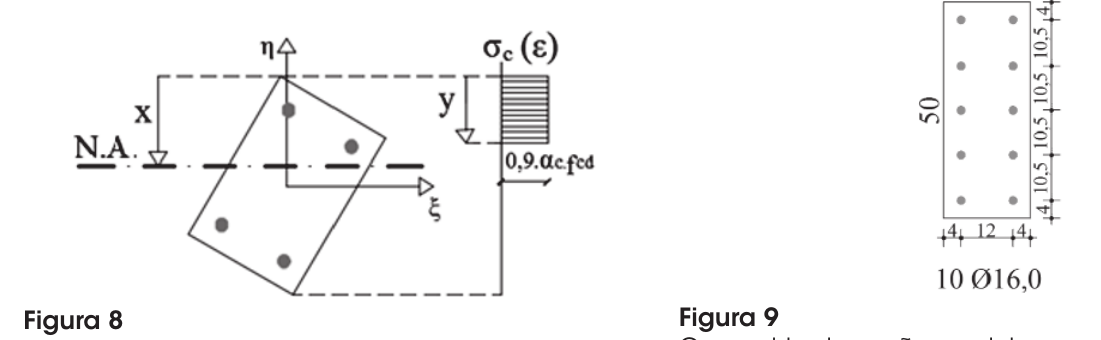
Geometria da seção modelo para estudo de